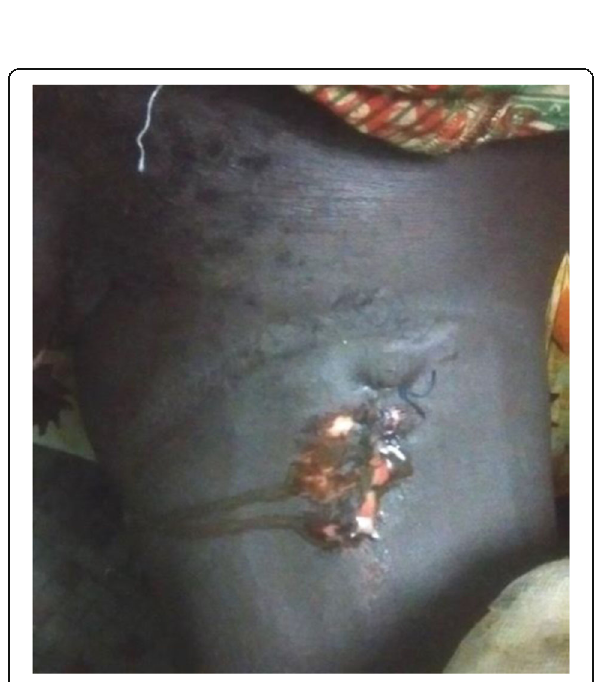
Fig. 3 Macroscopic image of a rupture of the urinary bladder dome (arrow). The blue star shows the end of Foley ’ s catheter